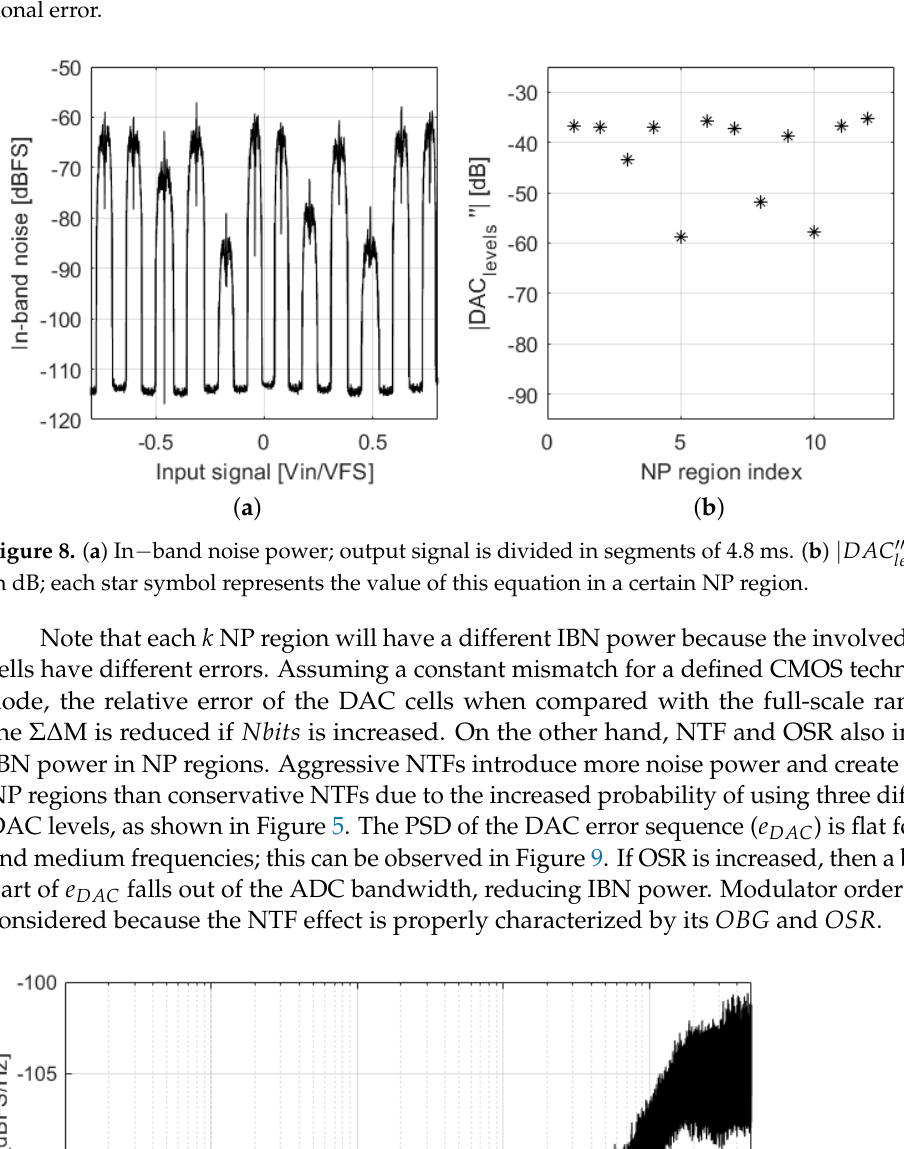
Figure 9. PSD of DAC mismatch error when input signal is in a NP